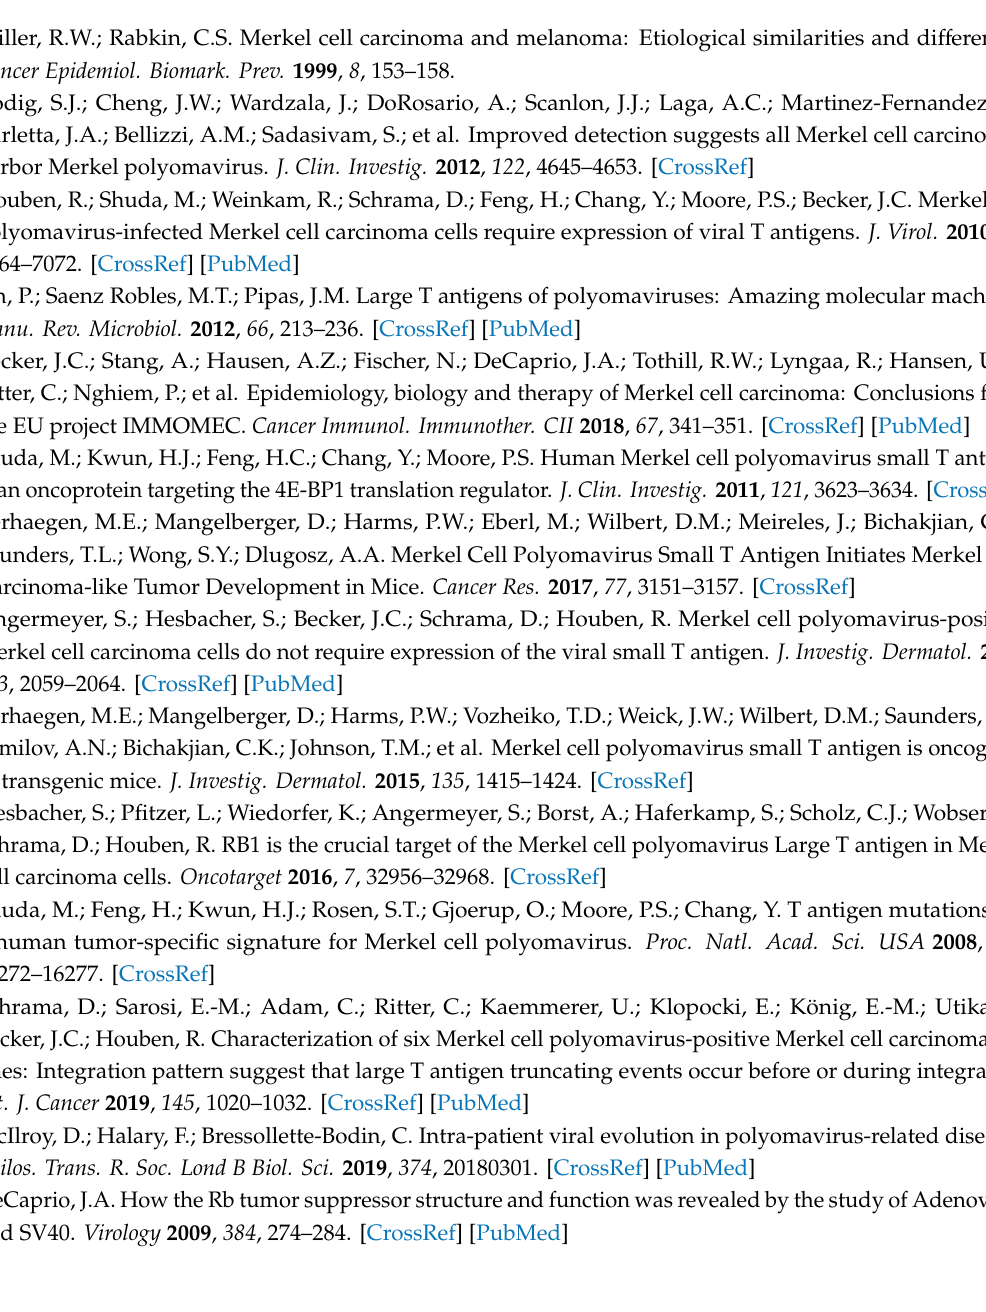
Figure S1: The weaker band observed for LT-mRuby-GMNN (Figure 3) is not due to reduced transcription from the retroviral vector. Figure S2: LT-mRuby-CDT1 rescues reduced DNA synthesis upon knockdown of endogenous MCPyV-LT as e ffi cient as LT-mRuby. Figure S3: LT-mRuby-CDT1 supports RB1 target gene expression as e ffi cient as LT-mRuby. Table S1: Primers used for real time